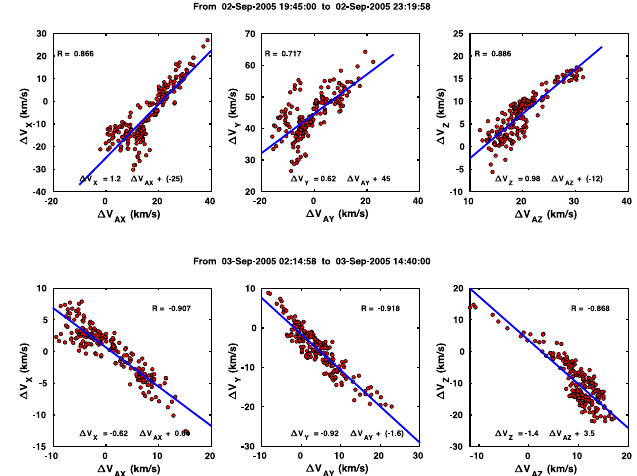
Figure 2. The time – frequency domain gives the correlation coef fi cient between V V i for the entire event. The bottom panel displays the changes in the A i and magnetic fi eld and proton velocity over time. The vertical dashed line shows the boundaries of the ( magnetic cloud ) MC and shock sheath of the ICME. For the above analysis, we use 3 s data from the WIND spacecraft.